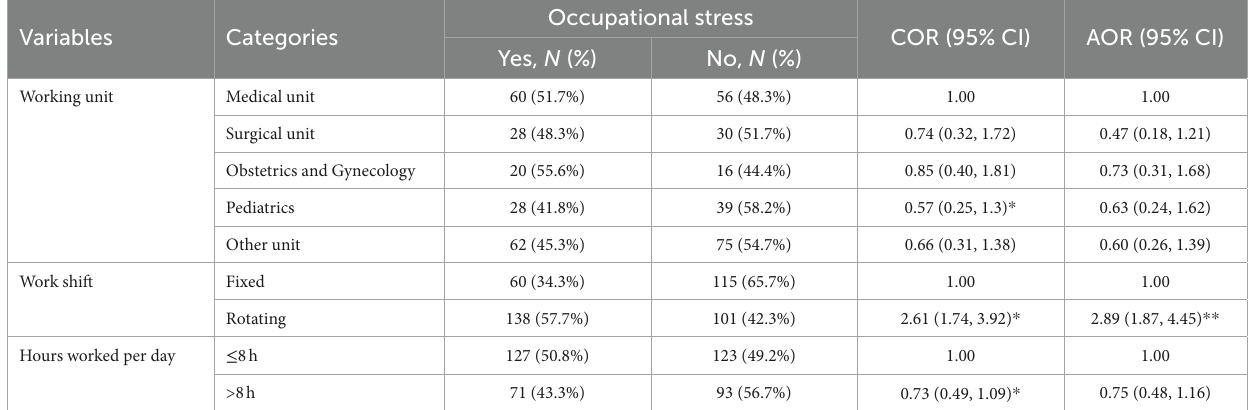
TABLE 5 Work place results of bivariate and multivariate binary logistic regression of factors associated with occupational stress among nurses working at public hospitals of Addis Ababa, Ethiopia, 2022 ( N = 414).